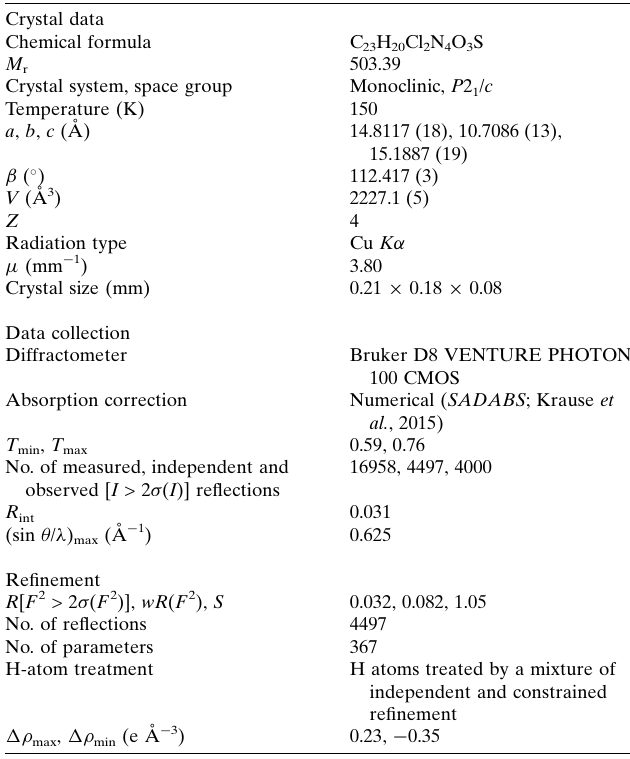
Crystal data Chemical